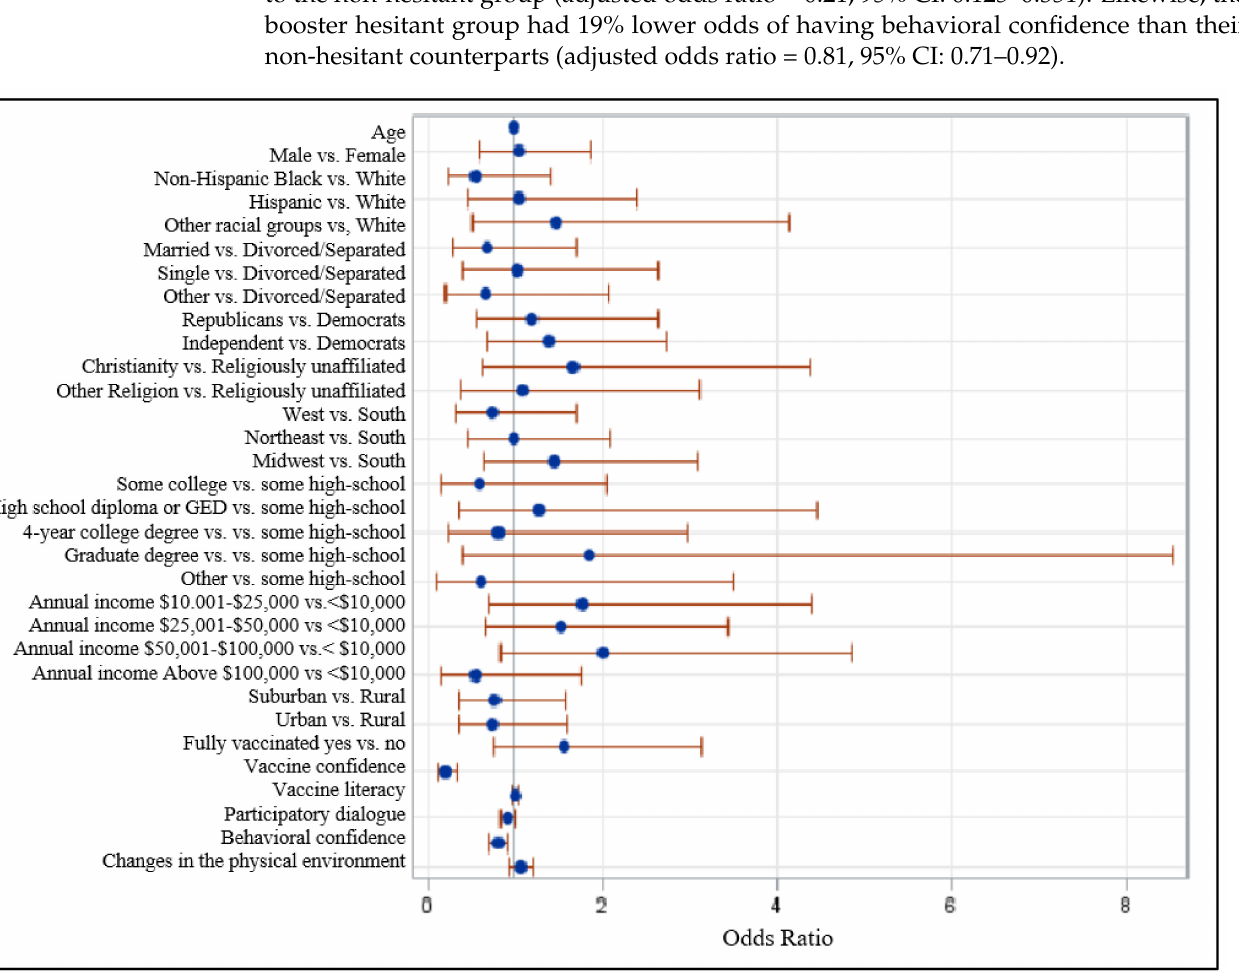
Figure 3. Forest plot showing odds rations and 95% Wald confidence intervals. Note: Probability modeled in booster hesitancy =